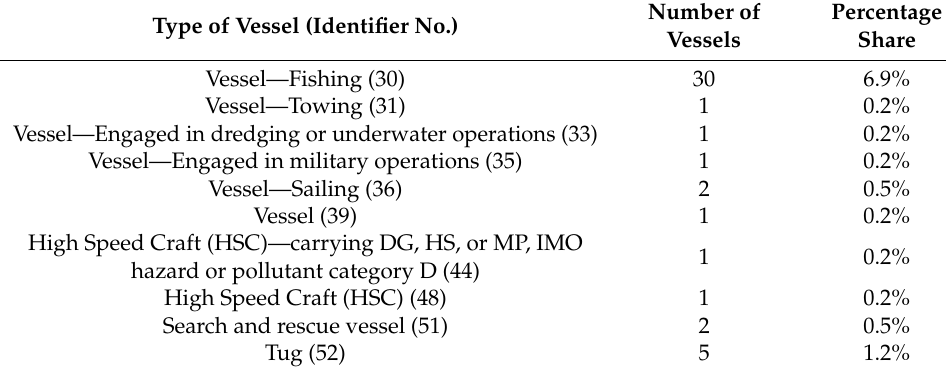
Table 9. List of ships on the measurement profile, broken down by type.